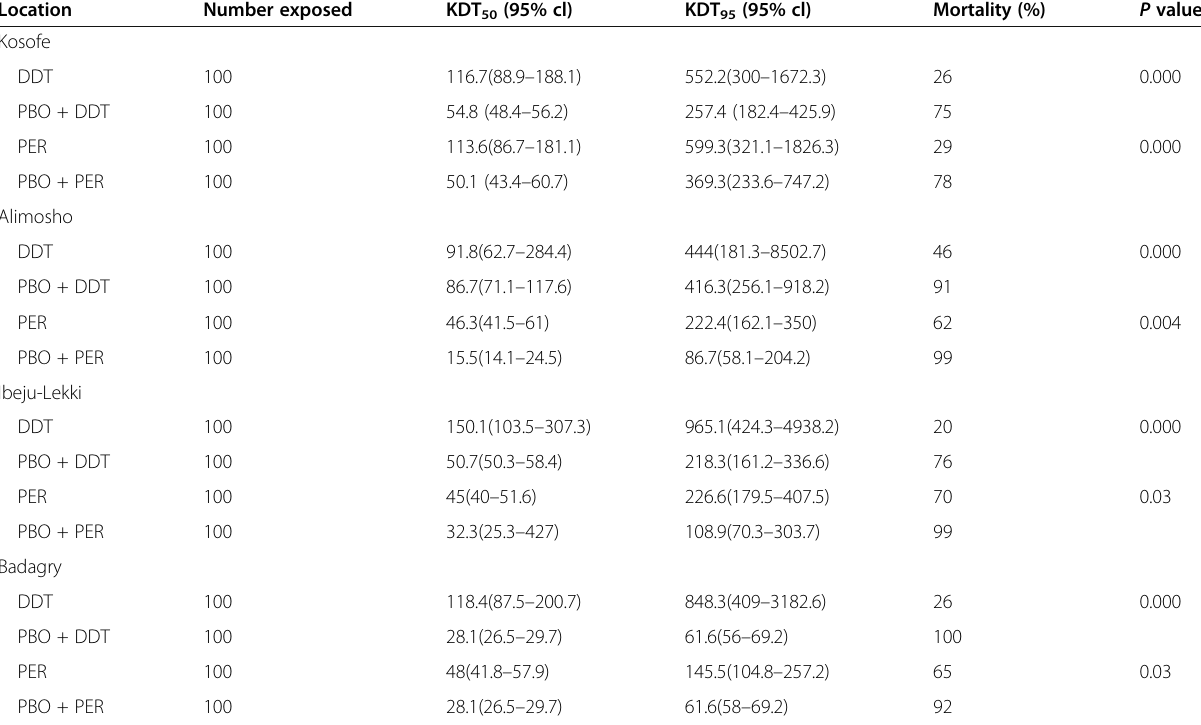
Table 1 The probit knockdown time (KDT 50 and KDT 95 ) values and percentage mortality of Aedes aegypti to DDT, permethrin, and PBO synergist in Lagos State